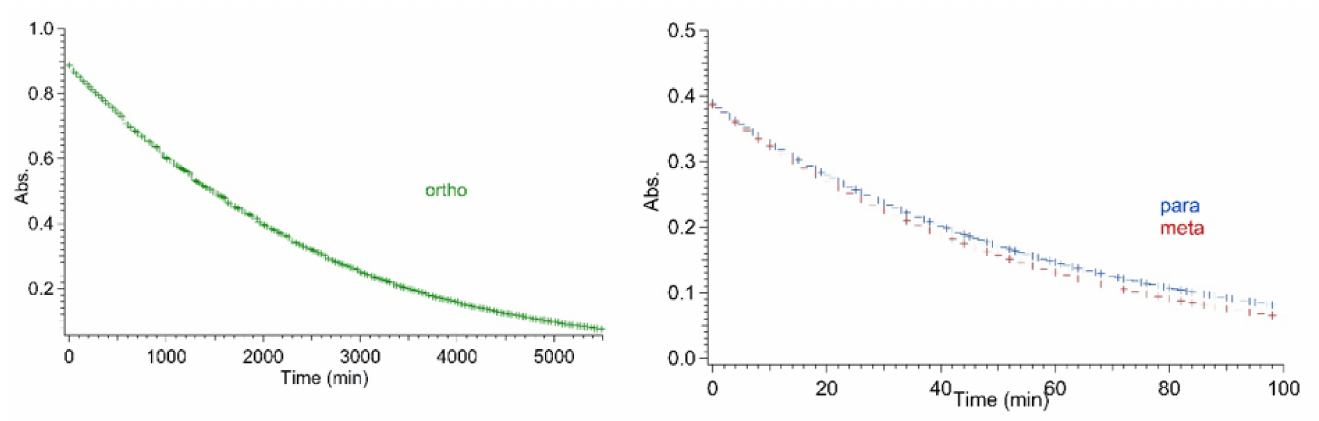
Figure 5. Comparison of VHF-Ph-I absorbance decay for ortho (left figure; green markers), meta and para (right figure; red and blue markers, respectively) derivatives at 35 ◦